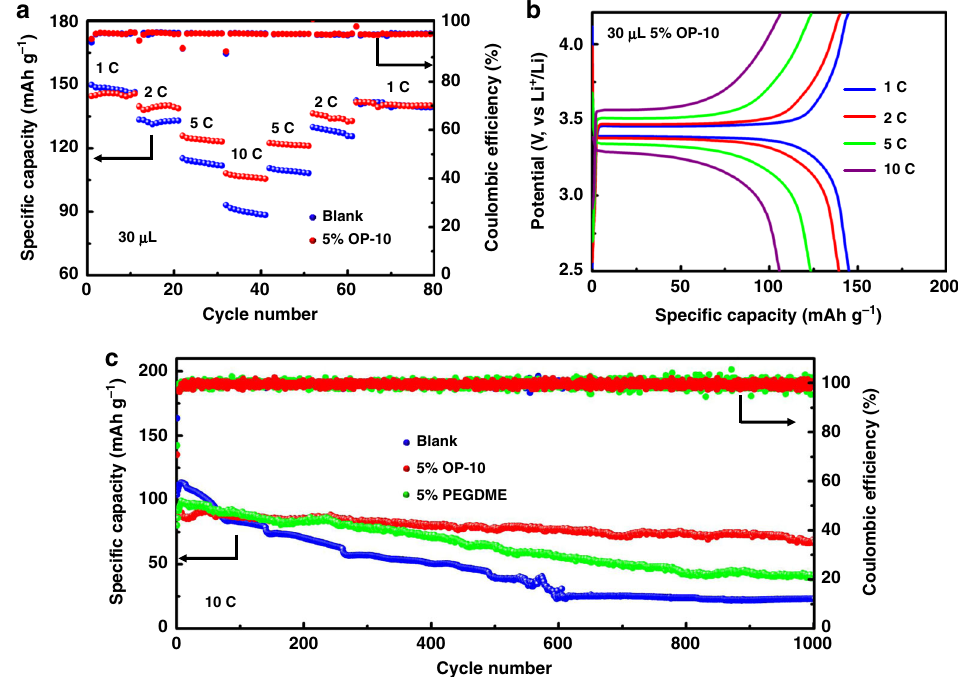
Fig. 6 Electrochemical performance of Li|LiFePO 4 full cells. Cycling performance at different rates ( a ), charge-discharge curves ( b ), and long-term cycling performance at 10 C ( c ) of Li|LiFePO 4 full cells in blank or modi fi ed